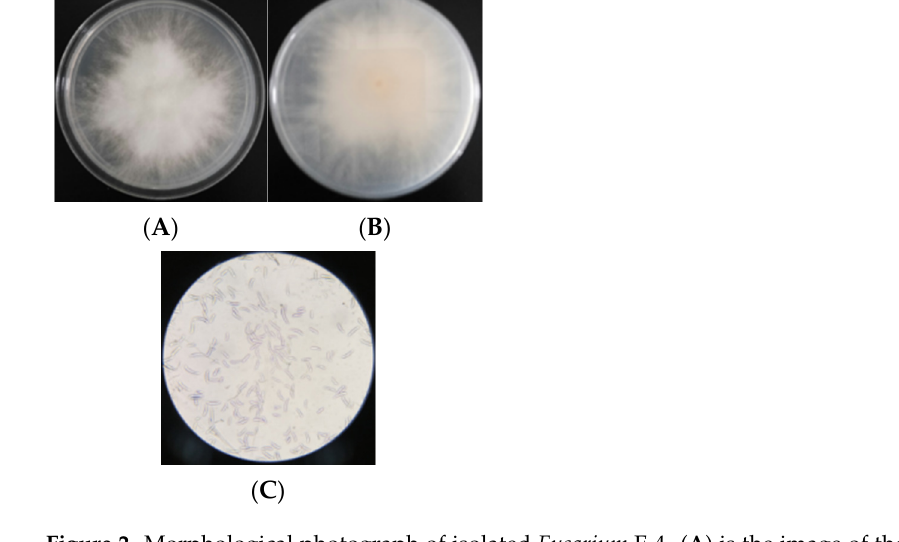
Figure 2. Morphological photograph of isolated Fusarium F-4. ( A ) is the image of the front of the petri dish, ( B ) is the image of the back of the petri dish, and ( C ) is the microscopic image of spores.